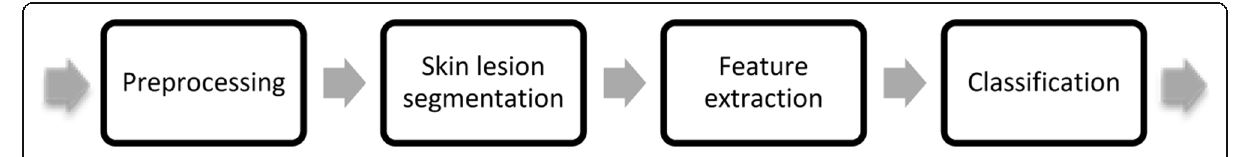
Fig. 1 Phases of the detection